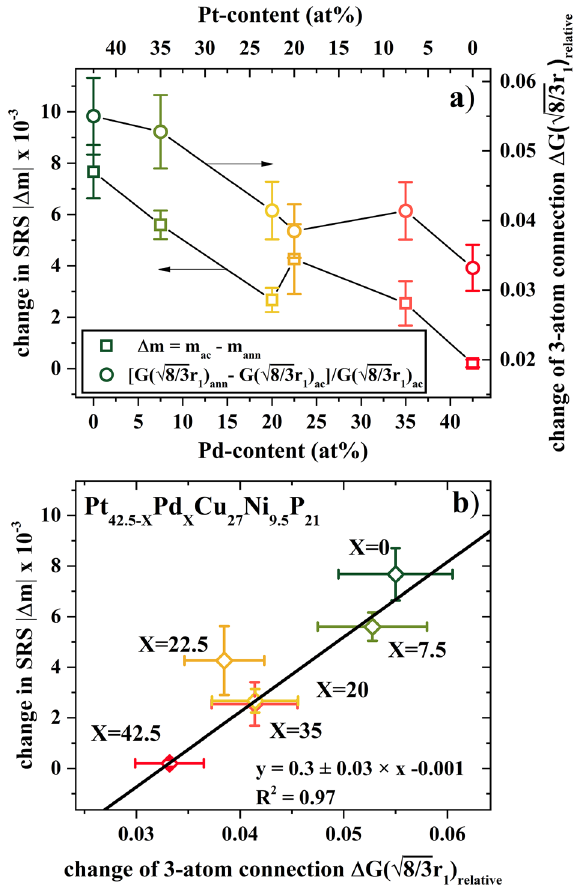
Figure 8. ( a ) Change in strain rate sensitivity (Δm) after annealing for 24 h at T g -50 K in reference to the as-cast state as a function of Pd-content (left axis, open squares) and relative change of reduced pair distribution function at the length scale of 3-atom connections ΔG( √ 8 / 3 r 1 ) relative after annealing for 24 h at T g -50 K in reference to the as-cast state as a function of Pd-content (right axis, open circles). ( b ) Scatter plot of Δm and ΔG( √ 8 / 3 r 1 ) relative showing the correlation of change in strain-rate sensitivity with increasing fraction of 3-atom cluster